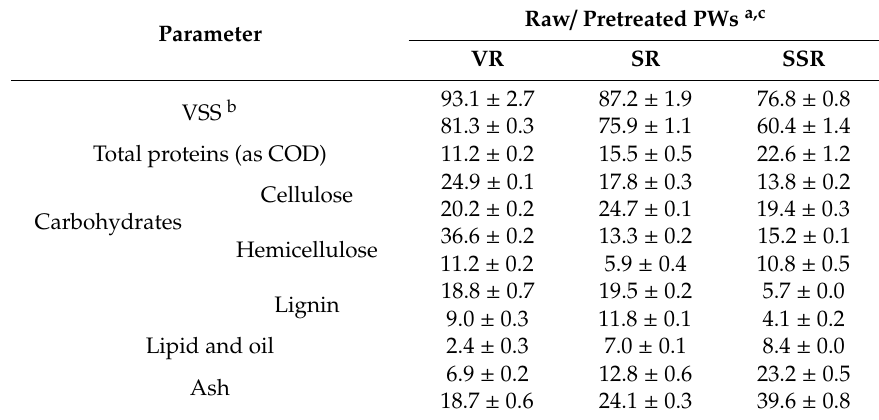
Table 2. The main characteristics of the raw / pretreated